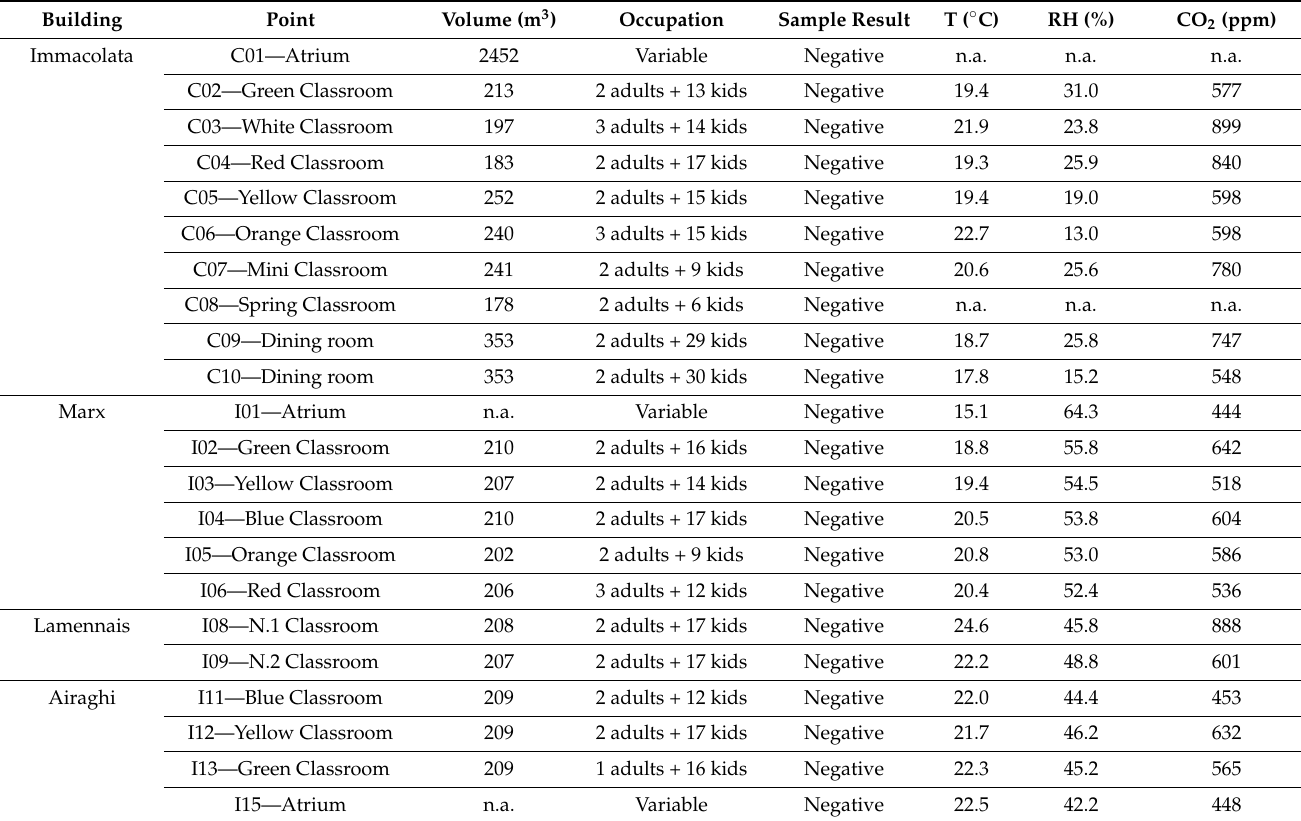
Table 3. Sampling points: room volumes, occupancies, sample results, and additional parameters measured in the rooms. The values of air temperature (T), air relative humidity (RH), and CO 2 concentration are averaged over the sampling